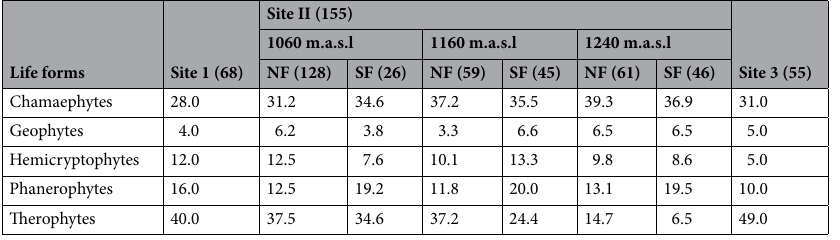
Table 4. Life form percentage (Actual counts between brackets) in the three sites of the studied area, NF, north facing; SF, south facing.